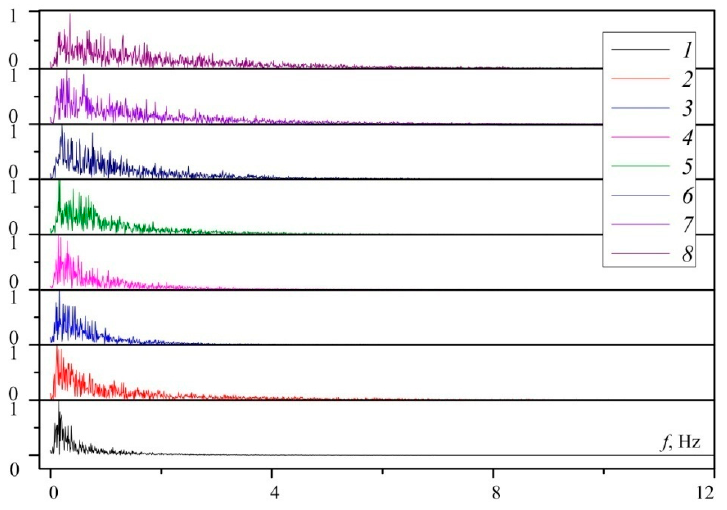
Figure 11. Spectra of temperature pulsations at different currents. Maxwell coil is turned off. 1 —100